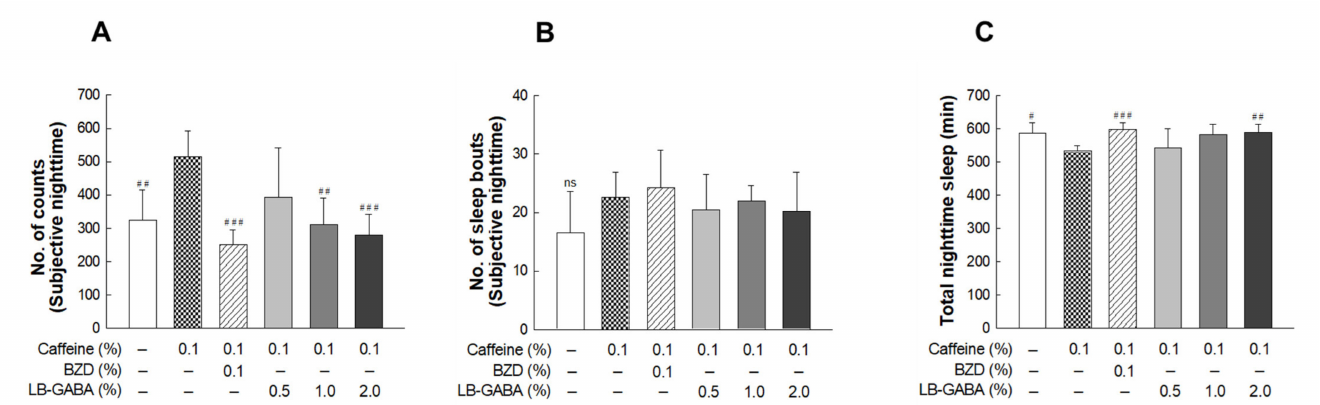
Figure 3. Effects of Lactobacillus -fermented γ -aminobutyric acid (LB-GABA) on Caffeine-induced Arousal in Fruit Flies. Locomotor activity of files was monitored for 3 days in constant darkness. ( A ) Subjective nighttime activity, ( B ) Number of sleep episodes. ( C ) Subjective nighttime sleep duration, comparing control (sucrose–agar medium), 0.1% alprazolam (benzodiazepine, BZD)-treated, and LB-GABA-treated (0.5, 1.0, and 2.0%) groups with 0.1% caffeine-treated group using Drosophila activity monitoring (DAM) system. Values are means ± standard deviation (SD); # p < 0.05, ## p < 0.01, and ### p < 0.001 versus caffeine group according to Tukey’s multiple comparison test. ns, not